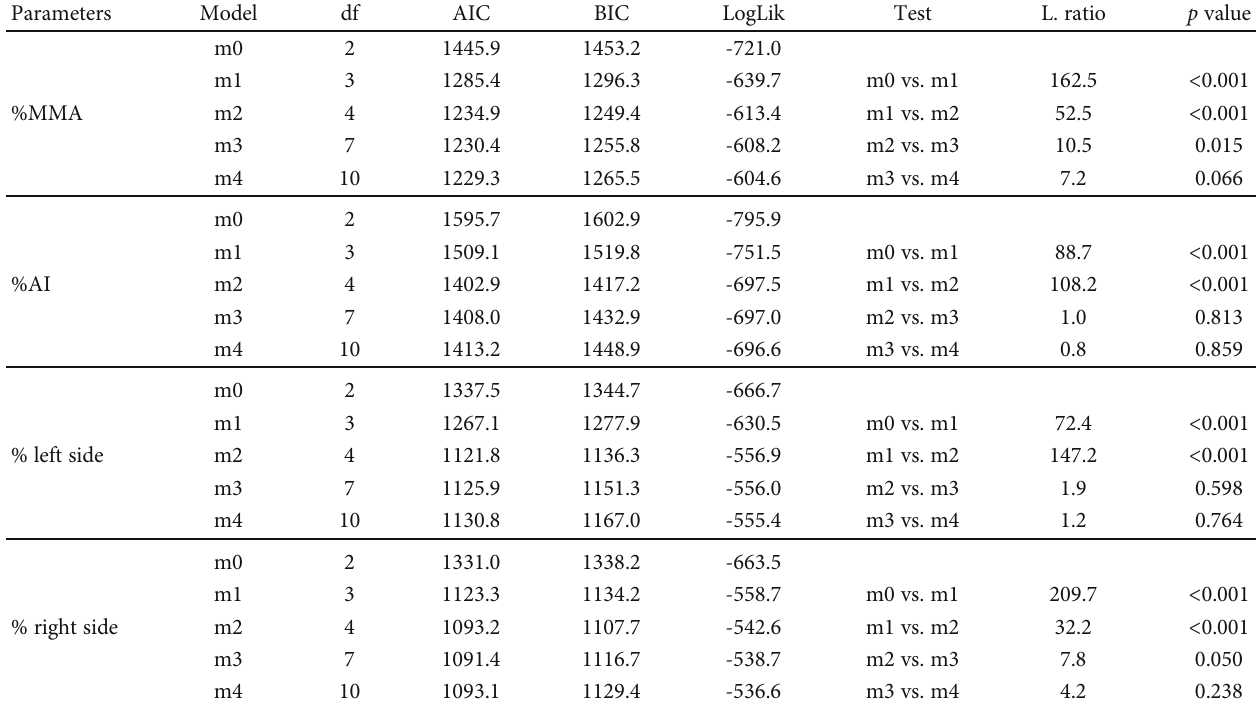
Table 3: FIT-SAT treatment e ffi cacy: best fi t mixed-e ff ect models. Information of the mixed-e ff ect models used for di ff erent kinematic